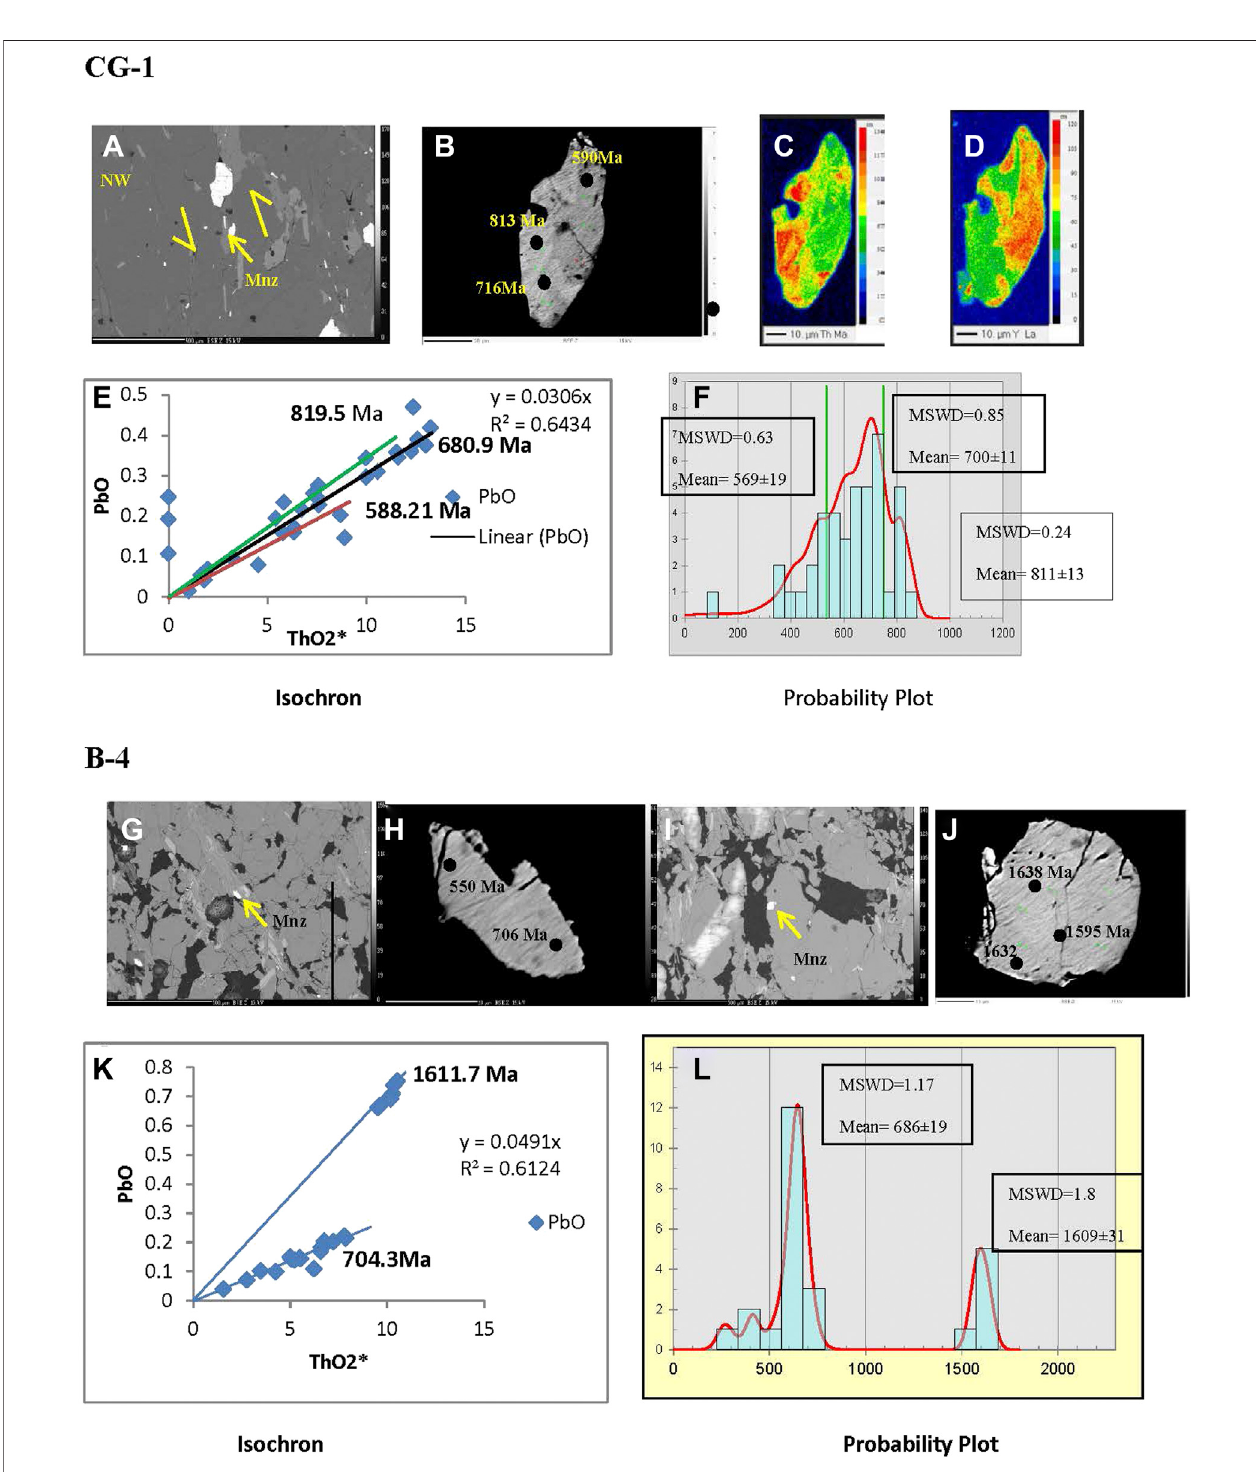
FIGURE8| SampleNo.CG-1, (A) BSEimageofmicaschistmylonitewithellipticalmonazitegrains,fromPhuladthrust,fromtheinclinationofthemonazitegrain,a top-to-NWsenseofshearisindicated, (B) 813and716agesareobtainedfromthehighThandlowYdomain,590 Maagefromfracturedpartofthegrain,whichislowin ThandhighinY(X-raymapsin (CandD) ). (E) Isochronshowsthreeages819,680,and588 Ma. (F) Probabilitycurveshowsthreepeaksas811,700,and569 Ma.First two ages from ‘ e and f ’ correspond to D 2 and last age corresponds to brittle deformation. Sample No. B-4 (G and I) BSE images of the upper amphibolite slivers containingellipticalandroundedmonazitegrains,withinPhuladthrust. (H) Ellipticalgrainisfracturedinthetopend.Thegrainyields706 Maand550 Maindicatingageof D 2 and brittle deformation. (J) Rounded grain does not show chemical variation and yields higher ages ca. 1,638 Ma that indicates pre-Delhi metamorphism. (K) Isochron and (L) probability graph display two age clusters, 1,611 – 704 Ma and 1,609 – 686 Ma, related to pre-Delhi metamorphism and D 2 ages.